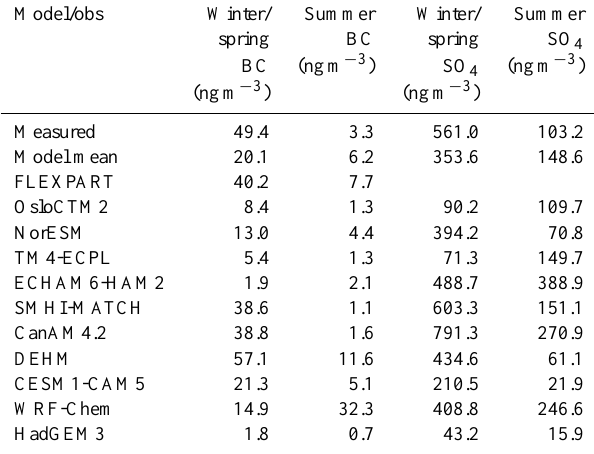
Table 2. Median observed eBC and modeled BC mass surface con- centrations in ngm − 3 as well as measured and modeled sulfate (SO 4 ) concentrations in the Arctic during winter/spring (January to March) and summer (July to September). The data used are from the years 2008 and 2009 and were averaged for the three stations Alert, Barrow and Zeppelin. Notice that some models do not cover the whole periods completely (see Table